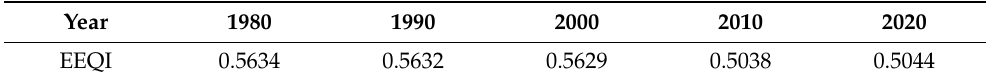
Table 4. EEQI of the QTP from 1980 to 2020.